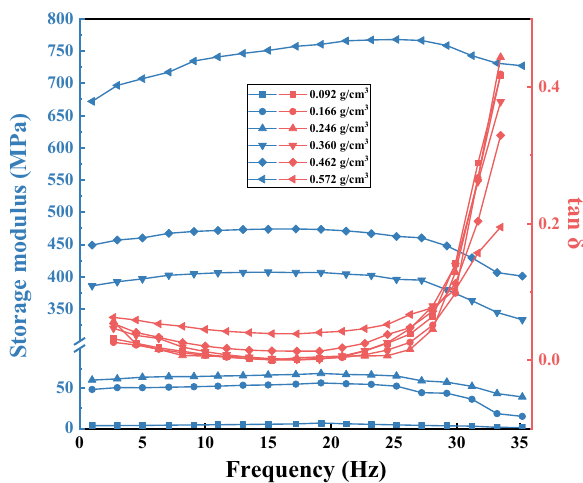
Figure 4: Frequency spectra of storage modulus and loss factor at di ff erent densities.